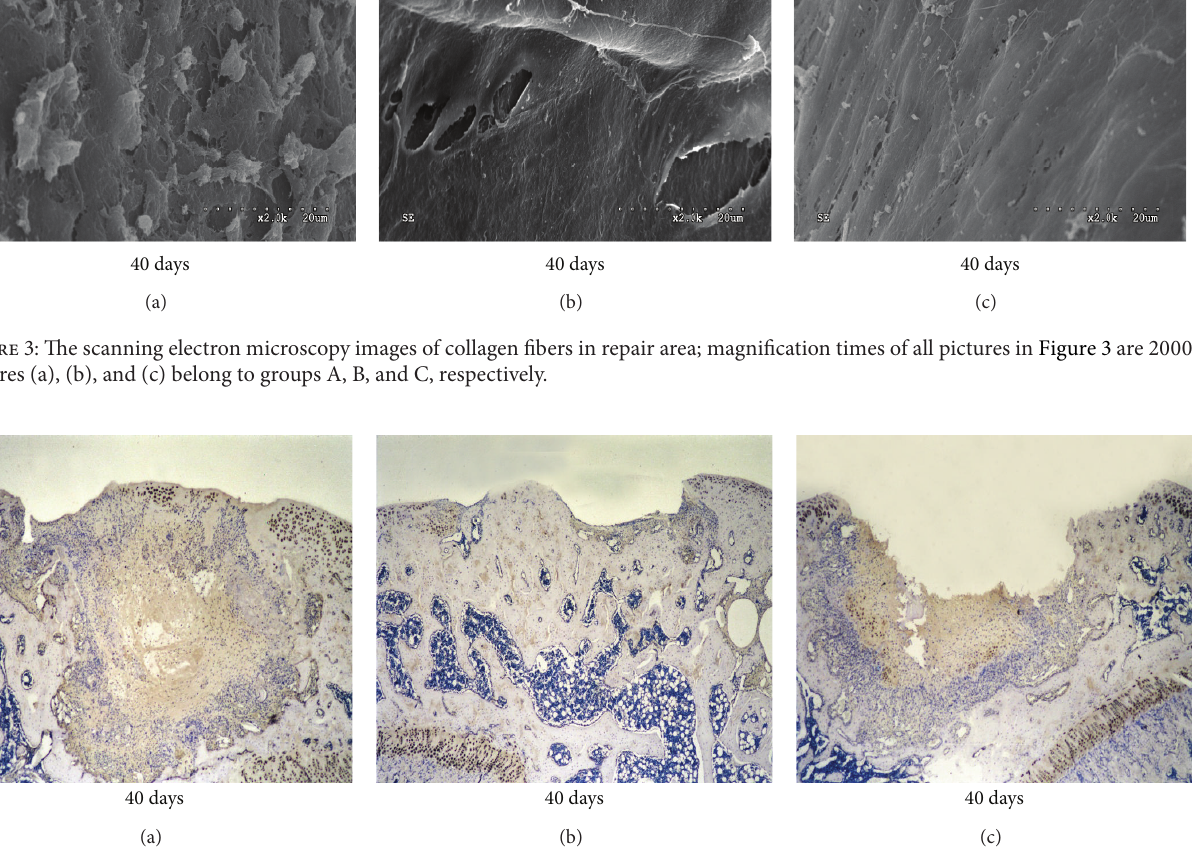
Figure 4: The results of immunohistochemical detection in restoration area; magnification times of all pictures in Figure 4 are 200. Pictures (a), (b), and (c) belong to groups A, B, and C,